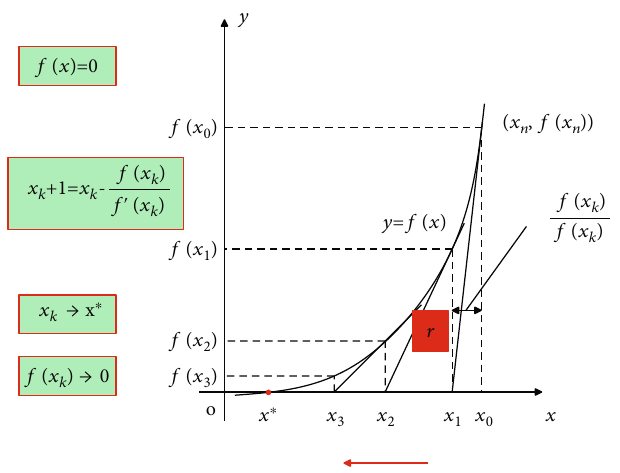
Figure 2: The iterative process of Newton ’ s method for solving